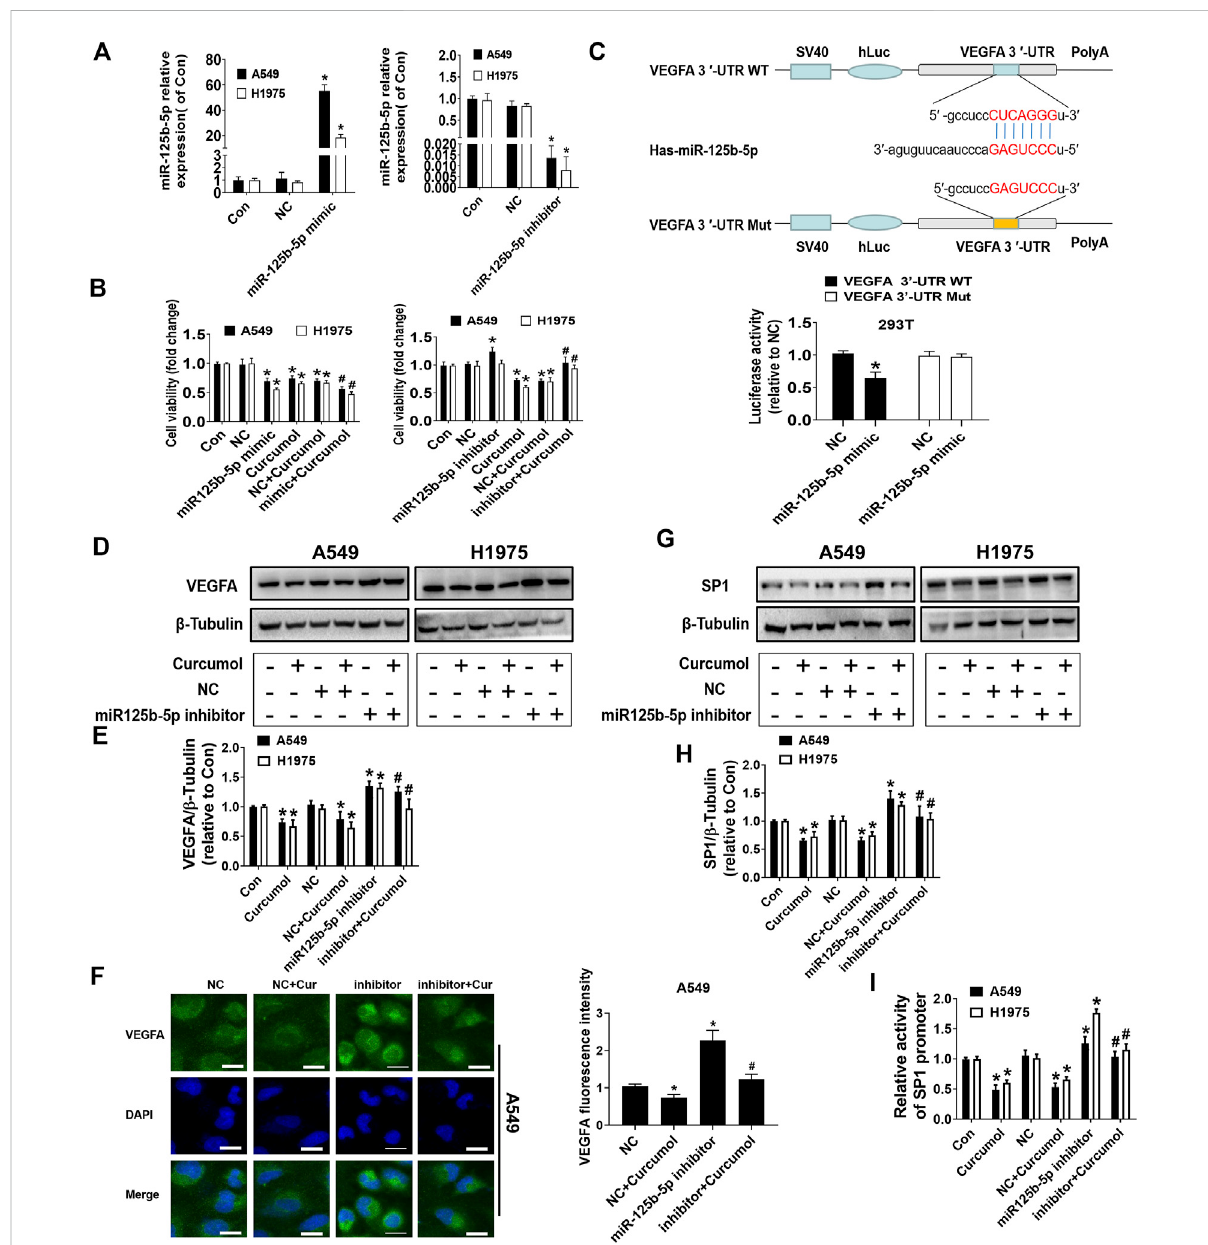
FIGURE 5 MiR-125b-5p mimics or inhititor modulated Curcumol-mediated cell viability, VEGFA and SP1 Expression. (A , B) Quanti fi cation of miR-125b-5p was shown after addition of mimics or inhibitor for 24 h. Subsequently, cell viability of A549 and H1975 were measured by MTT assay. (C) The luciferase reporter constructed with wild type or mutant VEGFA sequences were shown. 293T cells were transfected with VEGFA 3 ′ UTR-WT or VEGFA 3 ′ UTR-Mut vectors (0.5 μ g/ml each well) for 24 h, then transfected with miR-125b-5p mimics (50 nM) or NC for another 24 h. The luciferase activitywas detected on fl uorescence microplate reader. VEGFA protein wasdisplayed by (D,E) ,Westernblot analysis as well as (F) cellular immuno fl uorescence assay after transfection of miR-125b-5p inhibitor (50 nM) and addition of Curcumol (400 μ M). Scale bar, 20 μ m. (G , H) The bands of SP1 by Western blot analysis. β -Tubulin was used as internal control. (I) Dual-Luciferase Reporter Assay was carried out to detect SP1promoterluciferaseactivity.Thedataarepresentedfrom fi veindependentexperiments(n=5)runintriplicate.* p < 0.05,comparedwithcontrol (Con). # p < 0.05, compared with NC + Curcumol